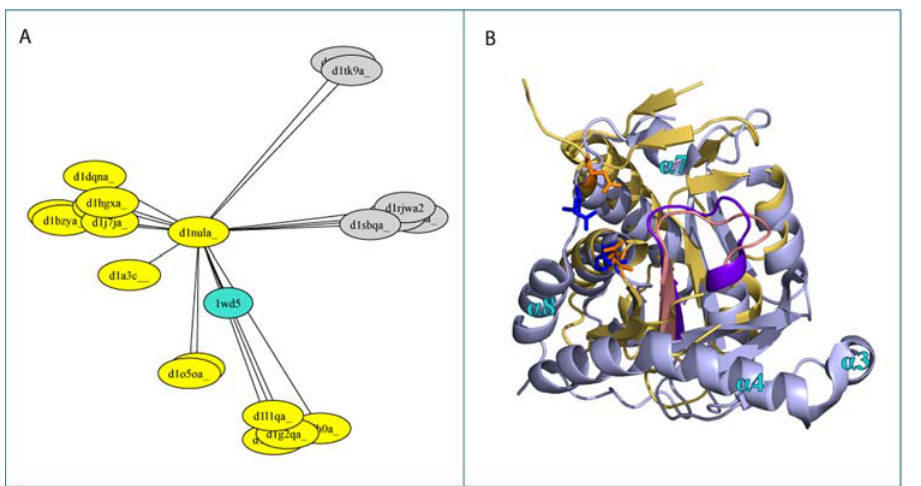
Figure 8. Query TT1426 (PDB 1wd5). A) Structural neighbors of hypothetical protein TT1426 (PDB 1wd5) according to TM-align. The image was generated by multidimensional scaling in the same way as Figure 4A. Proteins annotated with GO term GO:0016757 (glycosyltransferase activity) are colored yellow and they form a large group on the lower left, where the query is also located. The glycosyltransferase group is subdivided into subgroups. In general these subgroups are associated with different substrates, in particular adenine phosphoribosyltransferase (d1l1qa, d1g2qa), uracil phosphoribosyltransferase (d1o5oa, d1a3c), or xanthine/hypoxanthine/guanine phosphoribosyltransferases (d1nula, d1hgxa, d1dqna, d1j7ja, d1bzya). Proteins not annotated with GO:0016757 are colored grey. They are less structurally related to the query than the glycosyltransferases, and accordingly they group separately on the right and top. B) Structural superposition of query TT1426 (PDB 1wd5 [41] in light blue) and the nearest neighbor, xanthine phosphoribosyltransferase (ASTRAL d1nula [45] in gold). The conserved 5-phosphoribosyl-1-pyrophosphate (PRPP)-binding motif characteristic of type I PRTases is colored pink in 1wd5, and violet in d1nula. Residues Arg32 and Lys56 in the query 1wd5 are shown in blue sticks. They are likely to be functionally relevant (involved in binding the pyrophosphate [41]). The structurally equivalent residues in the nearest neighbor are shown in orange. The structural differences in helices a 3 and a 4, as well as in the substrate binding C-terminal hood region (helices a 7 and a 8), indicates that they might have different